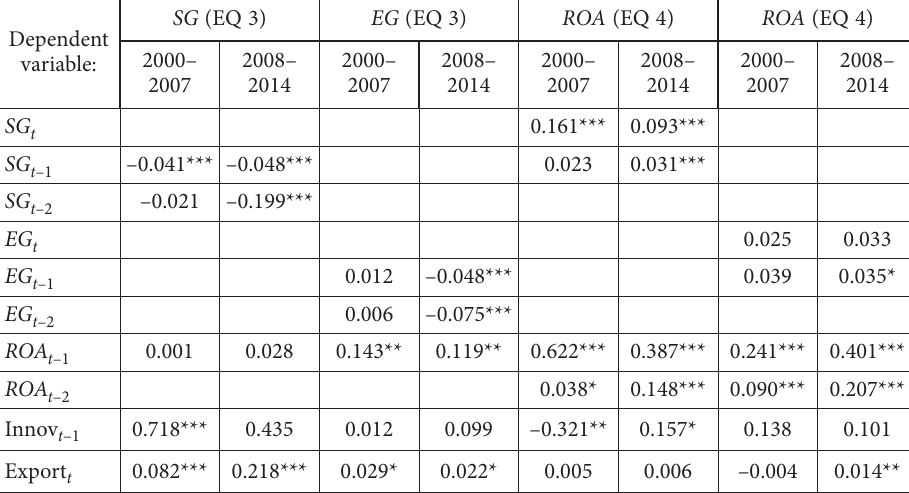
Table 6. System GMM regression results: strategies on profitability-growth relationship Dependent